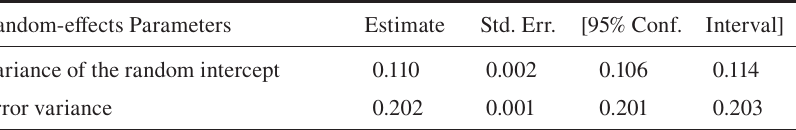
Variances of the multilevel model Random-effects Parameters